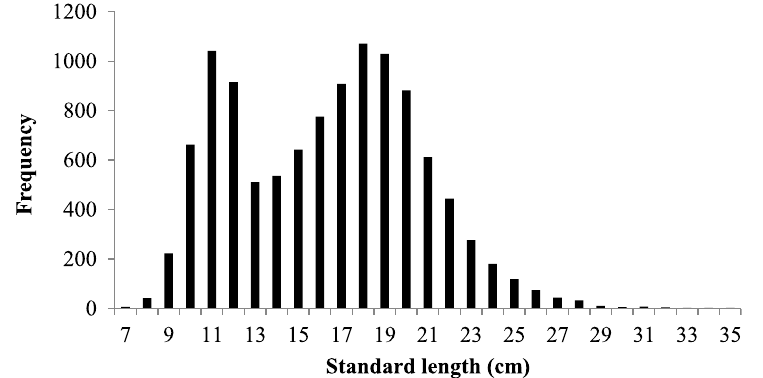
Fig. 3. Standard length frequency distributions of Coilia brachygnathus in the channel connecting Dongting Lake and the Yangtze River from July 2013 to July